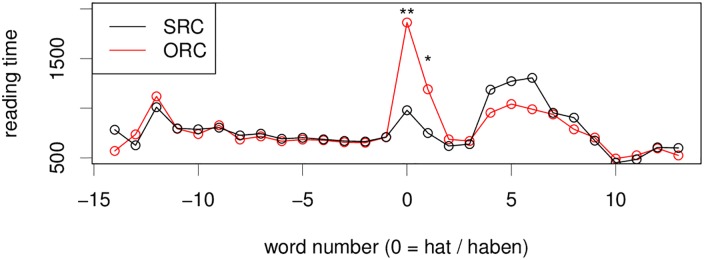
Self-paced reading times for the RC Experiment.Critical region hat/haben is located at word number 0. Extremely slow reading times in the ORC case are reflective of the high difficulty in this condition.